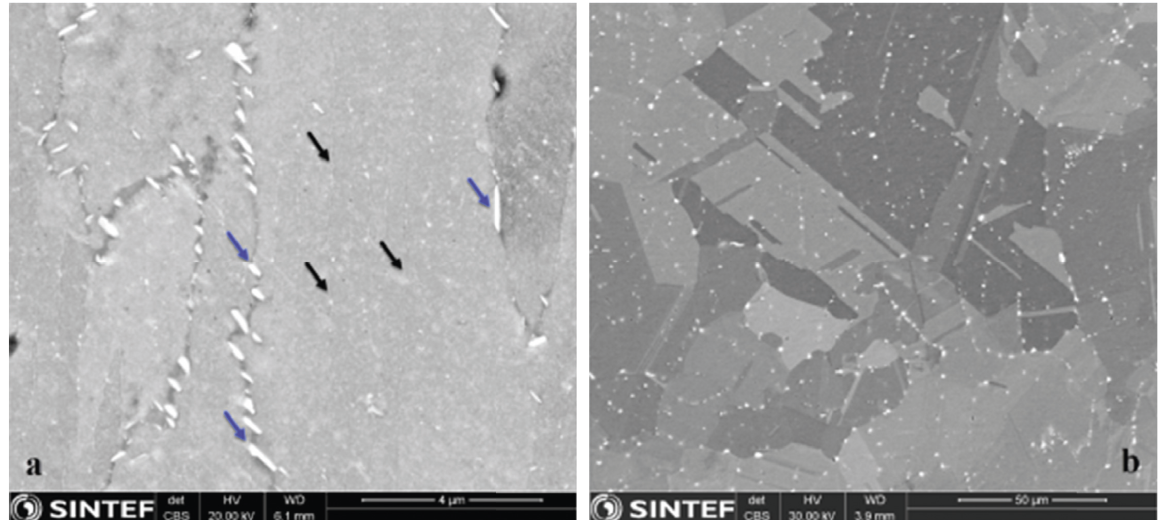
Figure 9: SEM micrograph of (a) aged IN718, and (b) HIPed and aged IN718. Black arrows show the interdendritic c + c ″ lamellae, and blue arrows show the evolution of grain boundary δ / η -phase upon ageing. Extensive reconstructions of the grain structure, and grain boundary precipitates mostly on the prior boundaries of c grains can be seen in